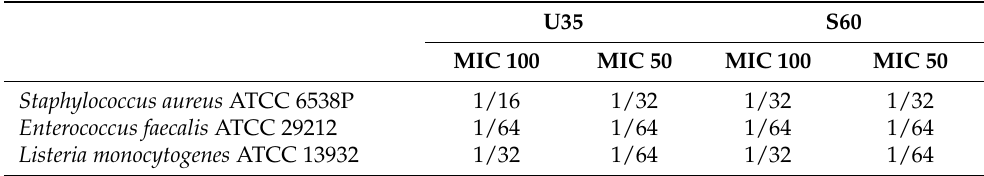
Table 9. Results for the MIC test performed for selected